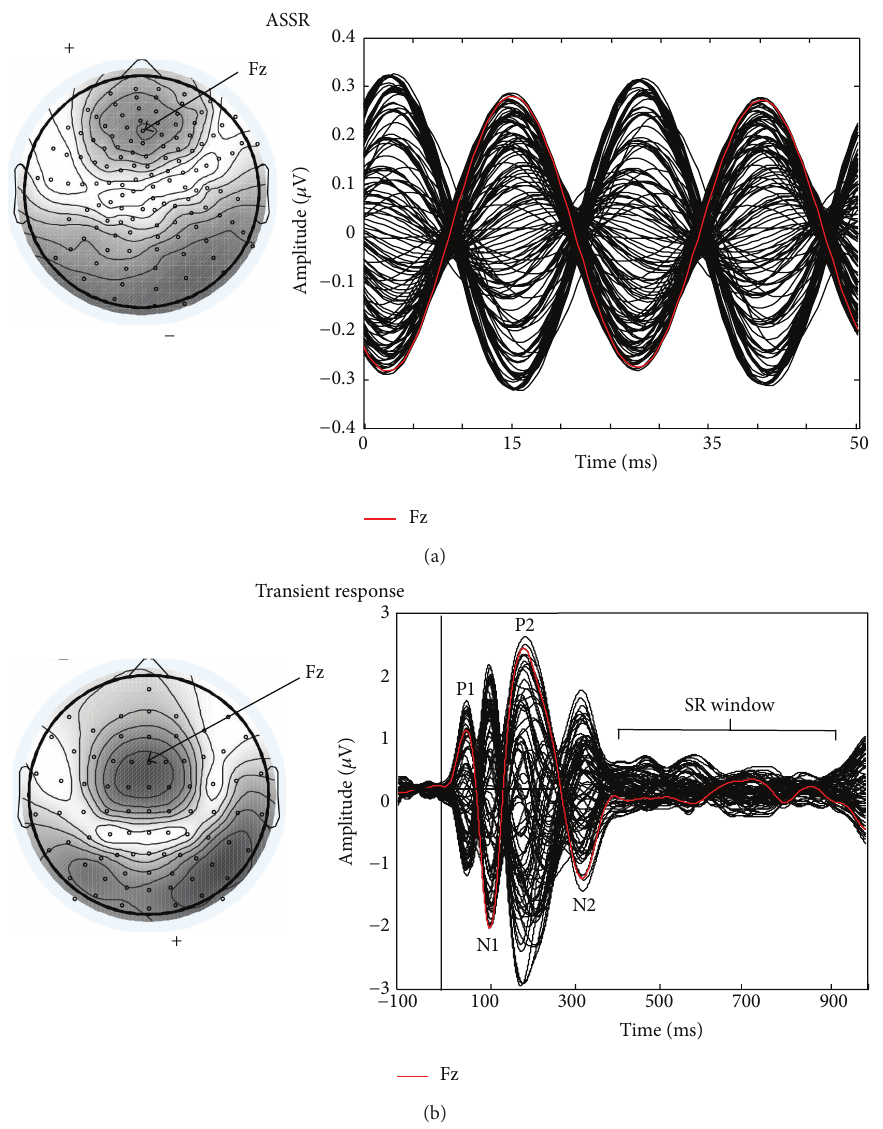
Figure 3: Representative topographies and time domain waveforms for the 40Hz auditory steady-state response (ASSR) and N1 response derived from the grand average of active trials from control subjects probed with a 500 Hz stimulus. (a) shows the ASSR during the interval 244–952 ms poststimulus, collapsed down to two 40Hz AM cycles. An alternating dipolar waveform is observed (one for each AM cycle). ASSR amplitude was calculated as the total field power of all electrodes in the two-cycle AM waveform. (b) A dipolar N1 is seen peaking at 100ms poststimulus. N1 amplitude was calculated as total field power at the peak of the dipolar waveform. The transient responses P1, P2, and N2 and the time range for the auditory sustained response (SR) are also labeled in the waveform. For the purpose of visualization, the trace in the right panel is high pass filtered at 2Hz to distinguish N2 from the SR which is attenuated as shown here. In each panel the Fz electrode is shown in